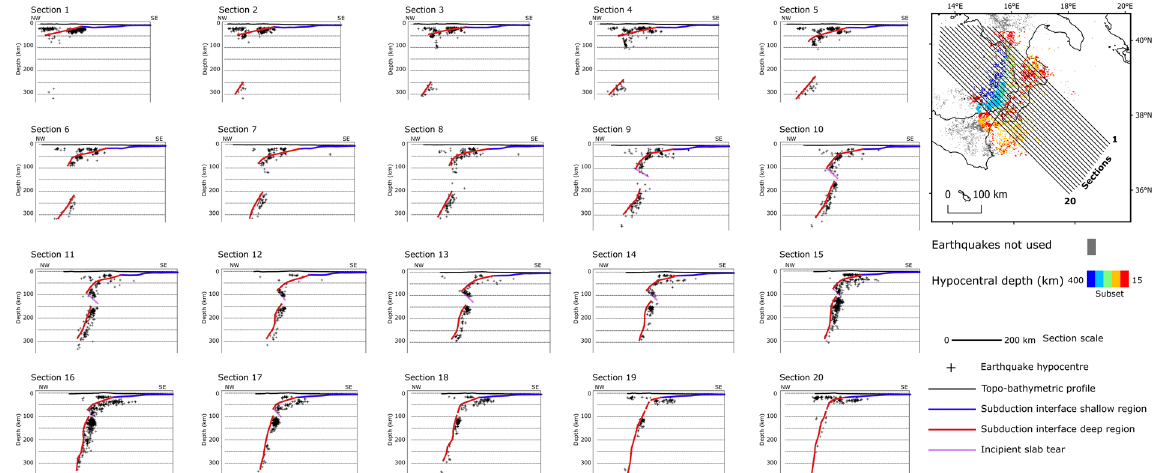
Figure 7. Seismicity distribution and reconstruction of the subduction deep region. Cross sections used for the interpretation of the deep slab. Section traces shown in map (upper-right corner). Earthquakes used for this interpretation are from the Italian Seismological Instrumental and Parametric Database 68 , time span 2005–2016, colour-coded in map view based on depth. Grey dots are earthquakes filtered out for depth < 15 km (upper crust